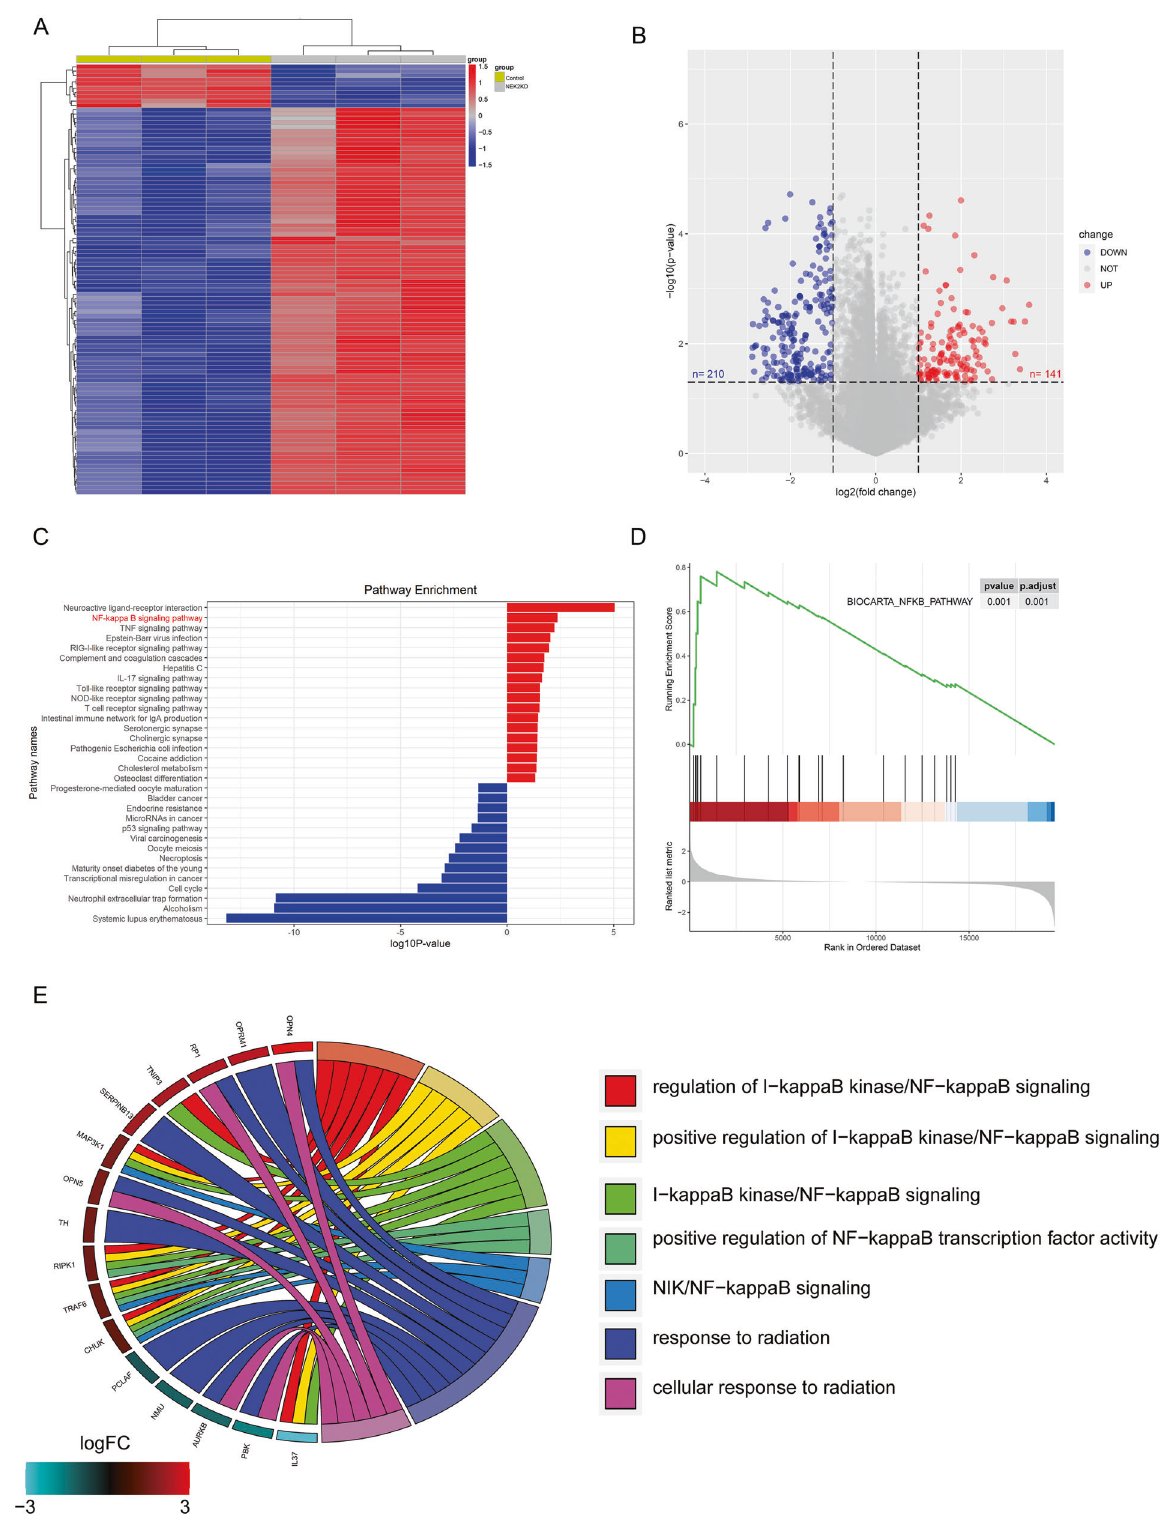
Fig. 4 NEK2 promoted gliomagenesis the malignancy of GBM via activation of NF- κ B signaling. A Hierarchical bi-clustering analysis was performed by using high-throughput RNA-seq data, indicating the signi fi cant gene signature in NEK2 knockdown 1763 cells compared with control 1763 cells. B Volcano plot for presenting the number of differentially expressed genes in NEK2 knockdown 1763 cells and control 1763 cells (log2FC > 1 or log2FC < − 1, with an adjusted P value < 0.05). C Kyoto Encyclopedia of Genes and Genomes (KEGG) analysis for exploring the positive correlation pathways of NEK2. D Gene set enrichment analysis (GSEA) analysis showed the positive correlation between NEK2 and NF- κ B signaling pathway. E Gene ontology (GO) analysis for differentially expressed genes in NEK2 knockdown group and control group.